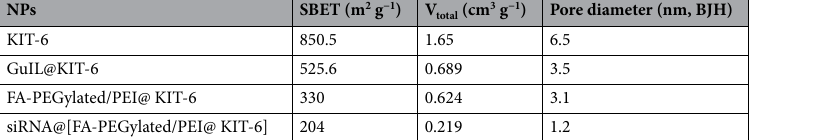
Table 1. The results of nitrogen adsorption/desorption for nanomaterials.